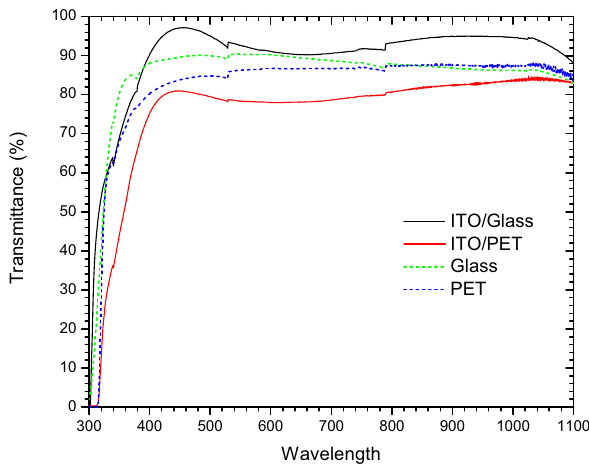
Figure 1: The transmittance of ITO on glass and PET substrates ( solid ) , and the transmittance of the glass and PET substrates ( dash line )